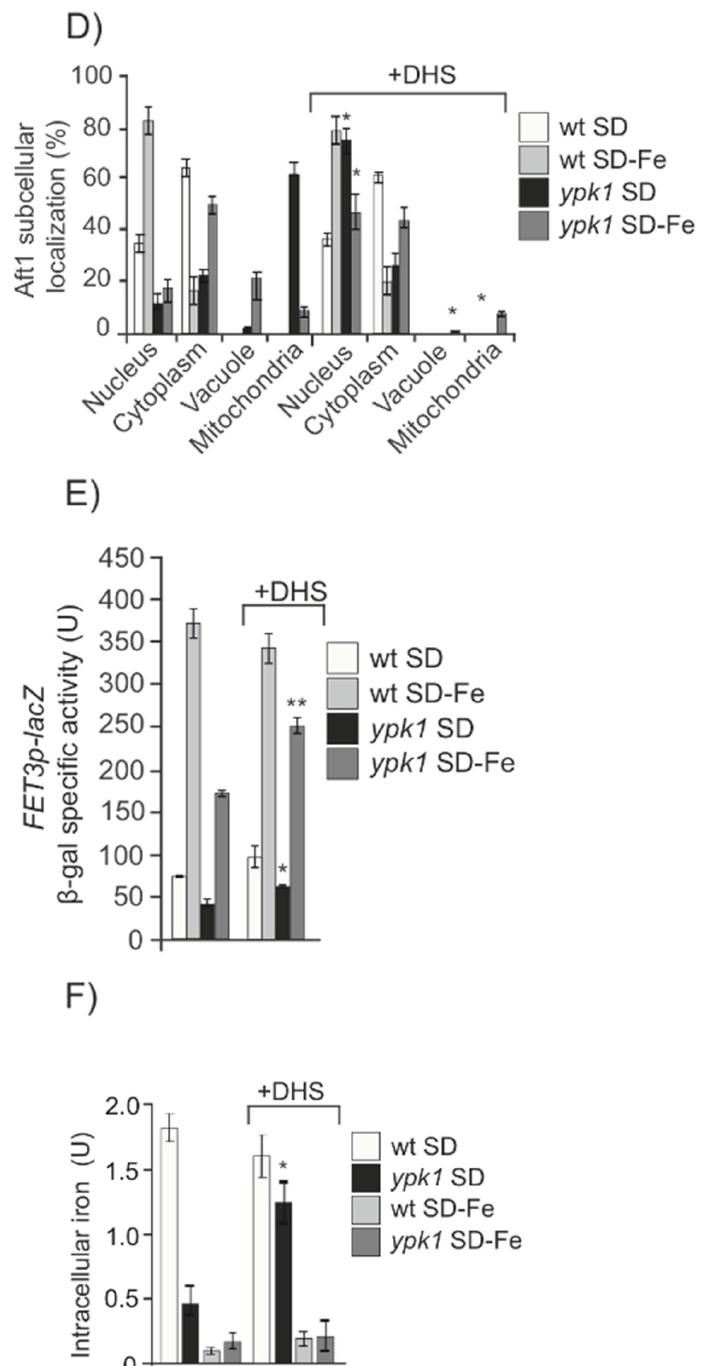
Figure 5. Levels of sphingolipids modify Aft1 localization. ( A ) wt strain transformed with pAft1GFP was grown in SD or SD-Fe medium with amino acids and treated or not with Myriocin (Myr) or Aureobasidin A (Aur) samples were taken at indicated times to analyze Aft1 subcellular localization ( B ) wt bearing p FET3 -LacZ was grown in SD or SD-Fe medium with amino acids and treated or not with Myriocin or Aureobasidin A. Samples were taken at 8 h. ( C ) Intracellular iron content in a wt strain grown in SD or SD-Fe treated or not with Myriocin or Aureobasidin A until the logarithmic phase. ( D – F ) Aft1 subcellular localization, ß-galactosidase activity and intracellular iron content, respectively, in wt and ypk1 strains grown exponentially in SD or SD-Fe and treated or not with DHS. * 0.05 > p > 0.01; ** 0.01 > p > 0.001. Downstream in the sphingolipids pathway, dihydrosphingosine (DHS), is a ceramide precursor, since it can be converted to ceramide by ceramide synthase (CerS),